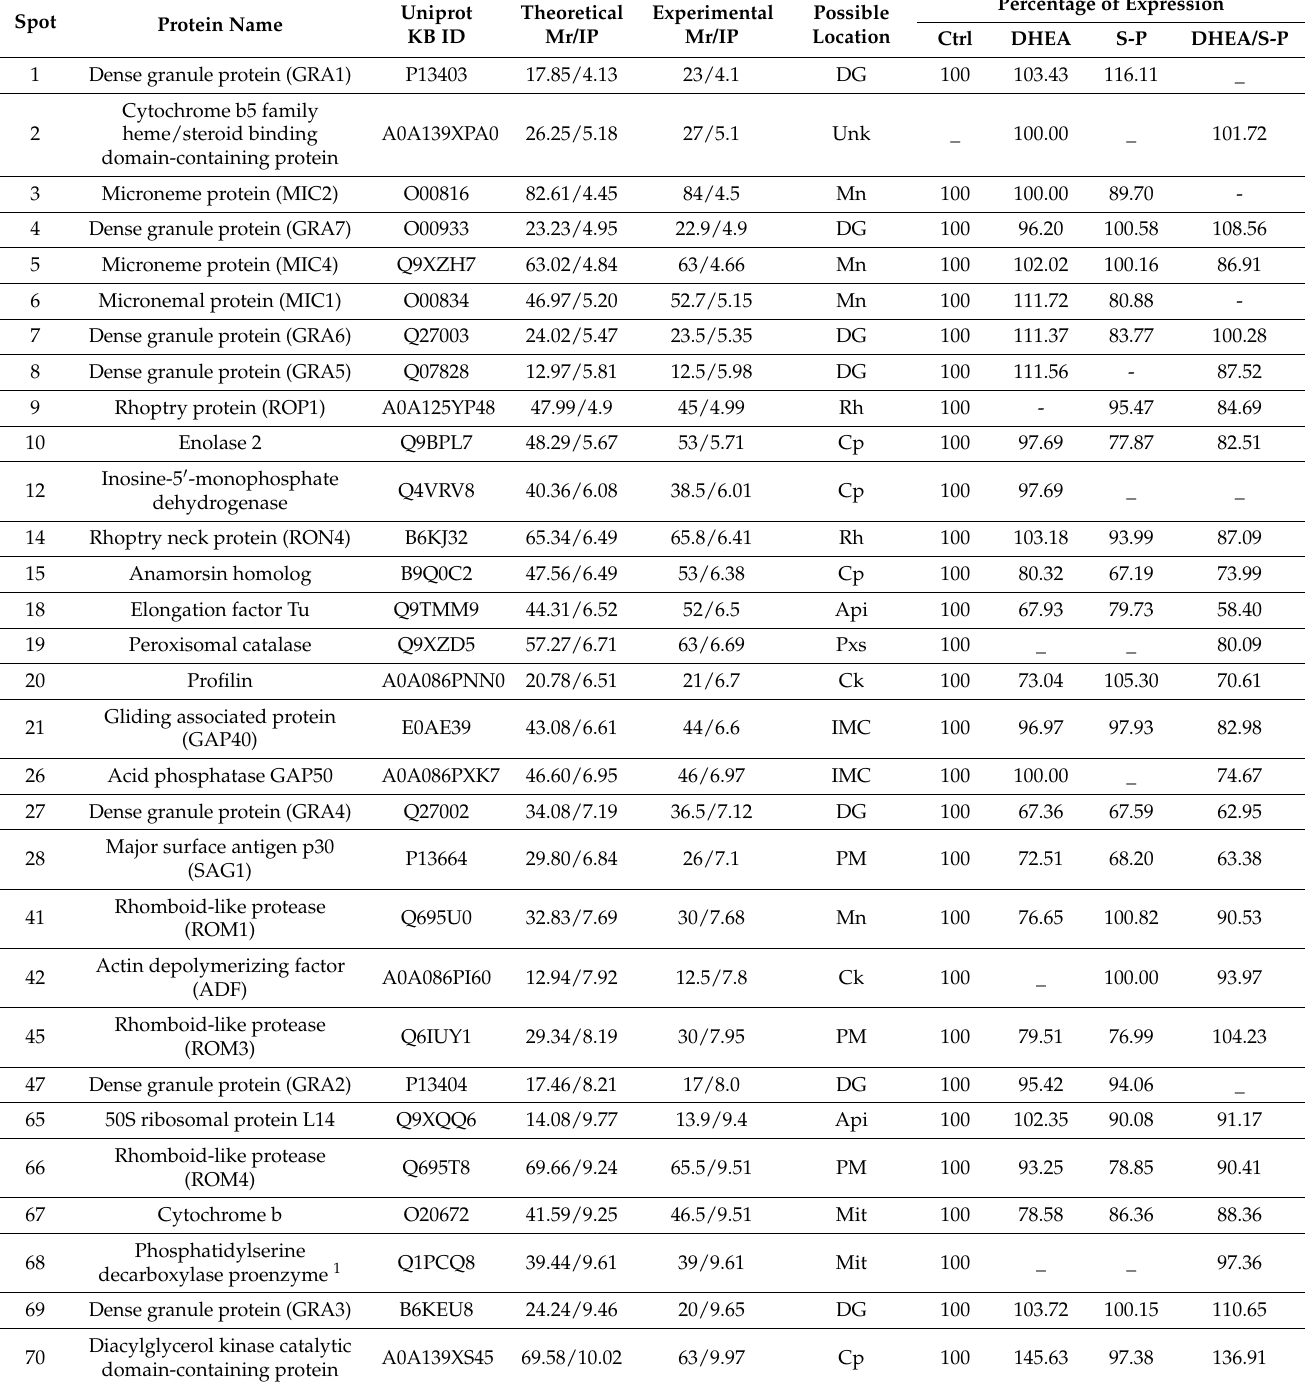
Table 1. Differential expression of prroteins in whole extracts of extracellular T. gondii